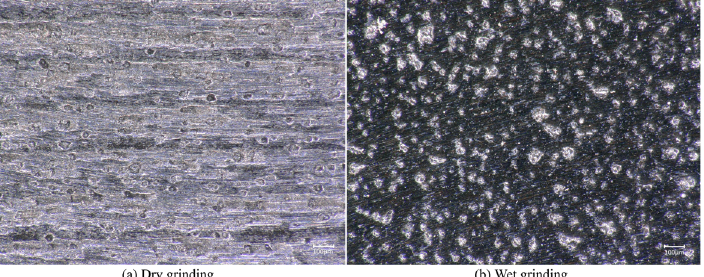
Figure 9. The optical image of the grinding surface (200×): ( a ) Workpiece surface after dry grinding,